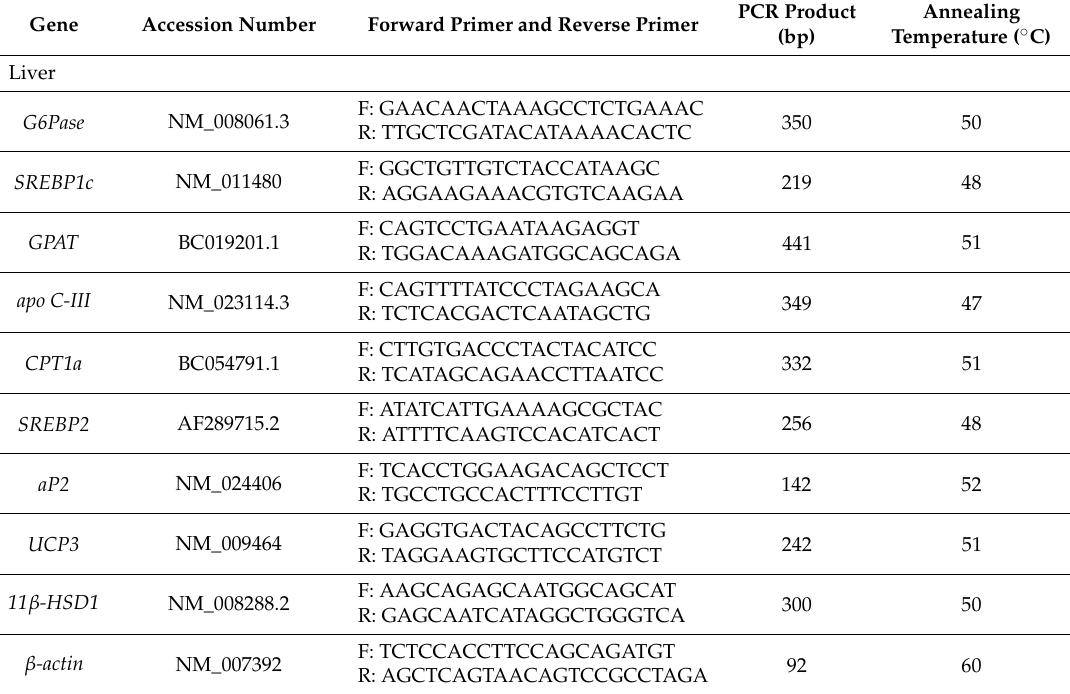
Table 2. Primers used in this